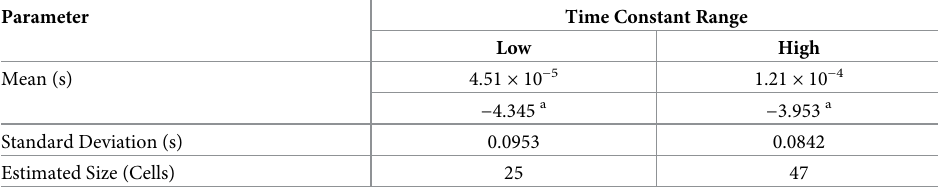
Table 2. Parameters of two lognormal